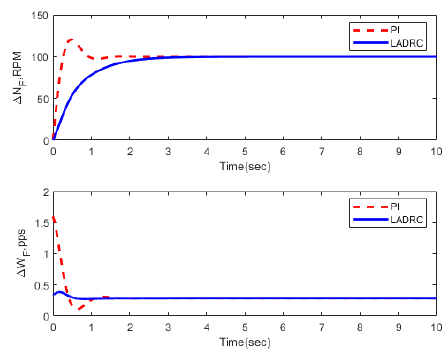
Figure 21. Step response of FC12.